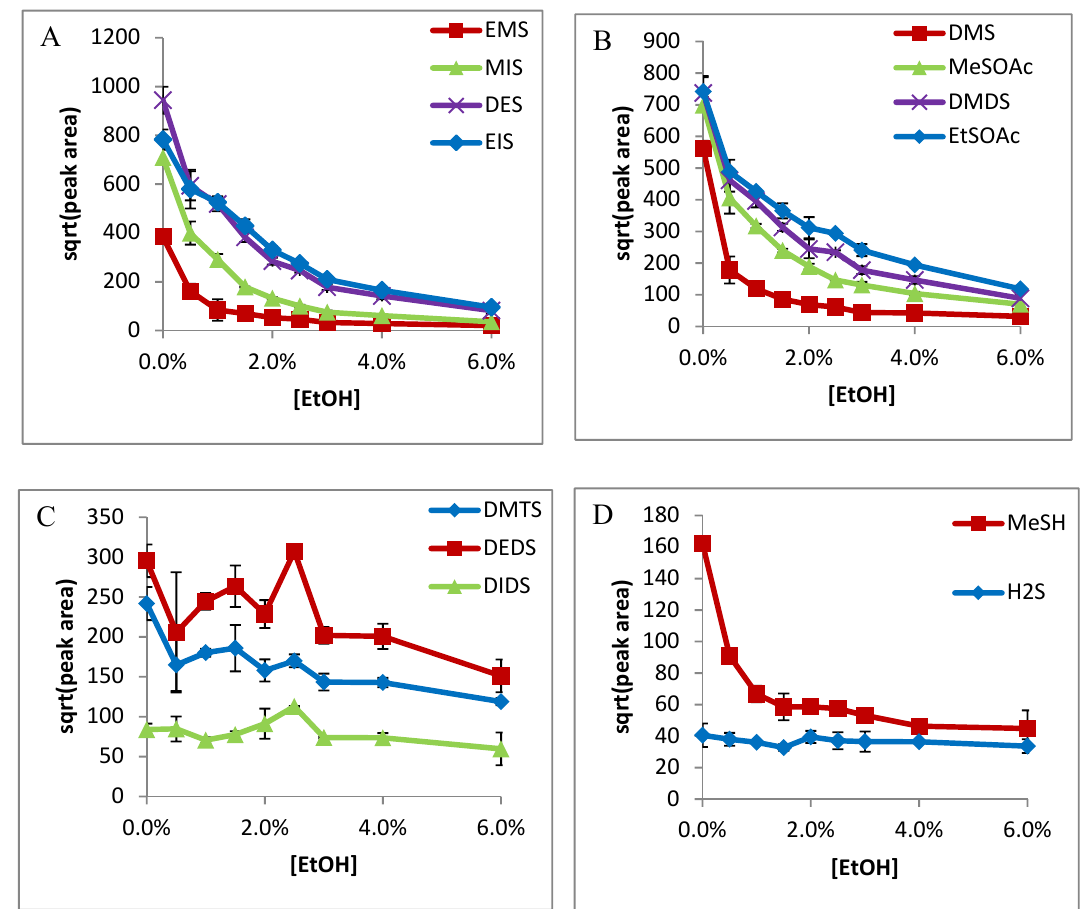
Figure 1. Effects of ethanol on the adsorption of the Carboxen-PDMS solid-phase microextraction (SPME) fiber of: A ) ethyl methyl sulfide (EMS), methyl isopropyl sulfide (MIS), diethyl sulfide (DES), and ethyl isopropyl sulfide (EIS); B ) dimethyl sulfide (DMS), methyl thioacetate (MeSOAc), dimethyl disulfide (DMDS), and ethyl thioacetate (EtSOAc); C ) dimethyl trisulfide (DMTS), diethyl disulfide (DEDS), and diisopropyl disulfide (DIDS); D ) methanethiol (MeSH) and H 2 S.